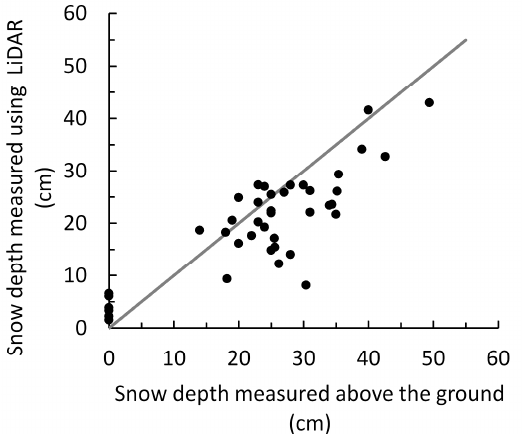
Figure 6. Relation between snow depth obtained by ground measurement and that obtained by LiDAR. The solid line indicates the y = x line.